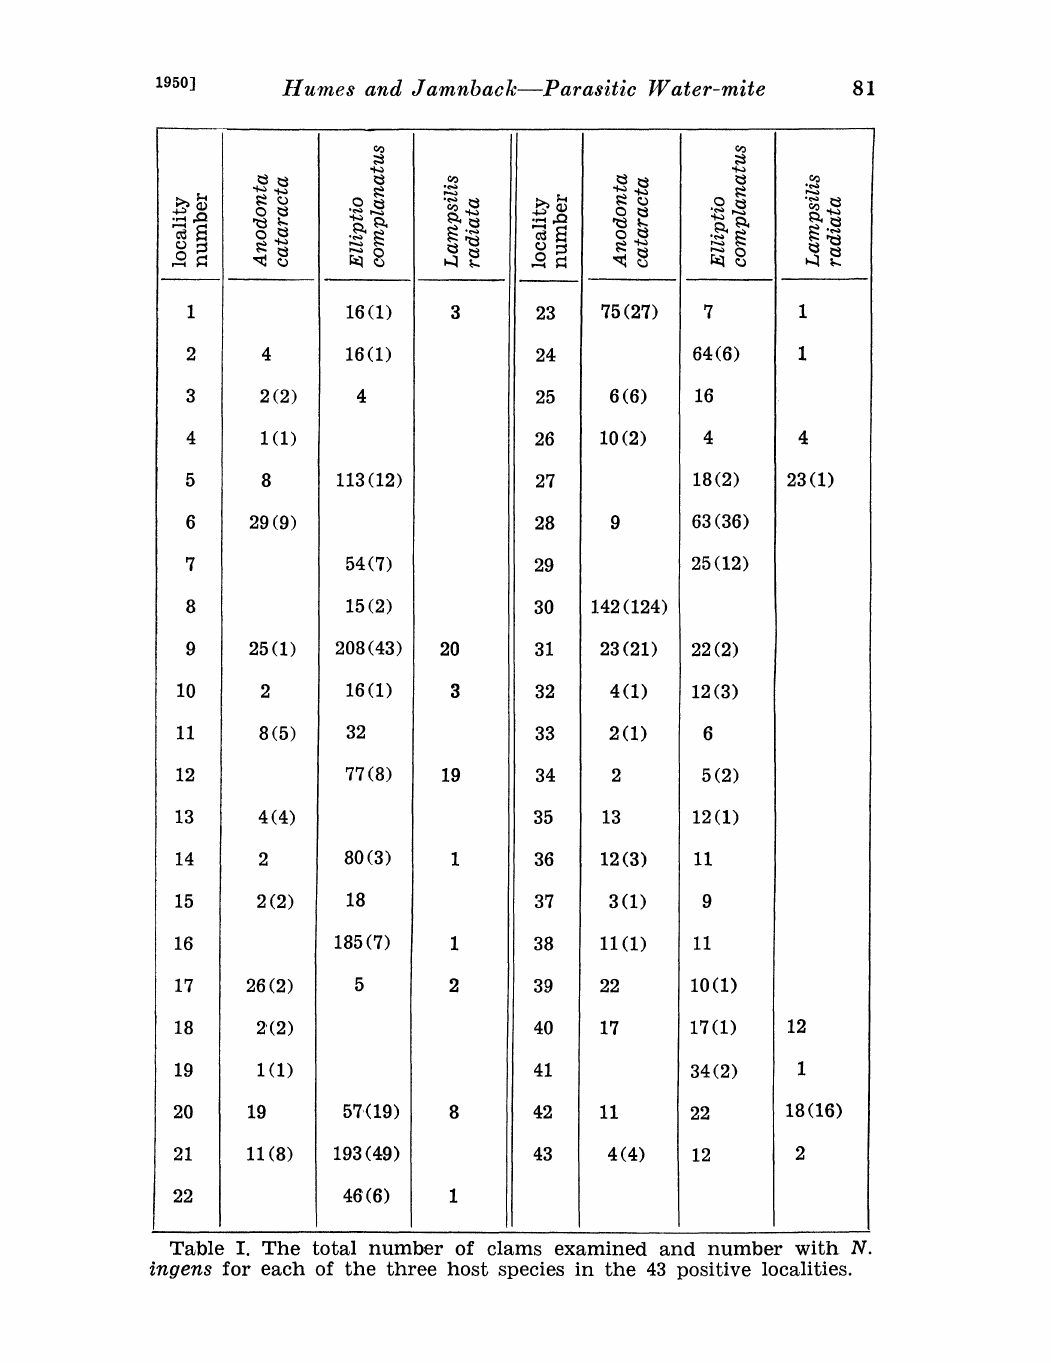
Table I. The total number of clams examined and number with N. ingens for each of the three host species in the 43 positive